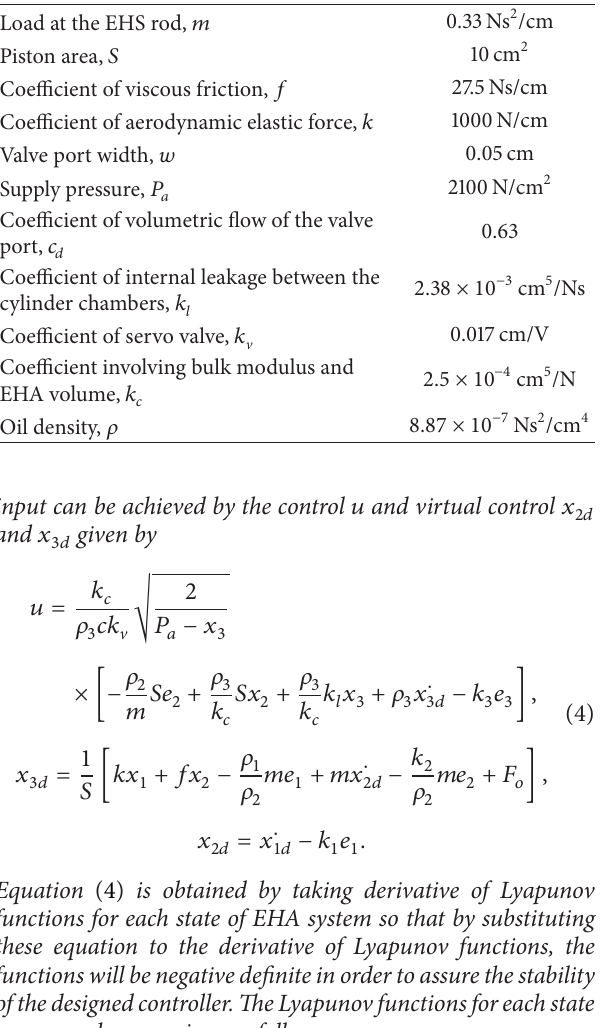
Table 1: Parameter of EHA